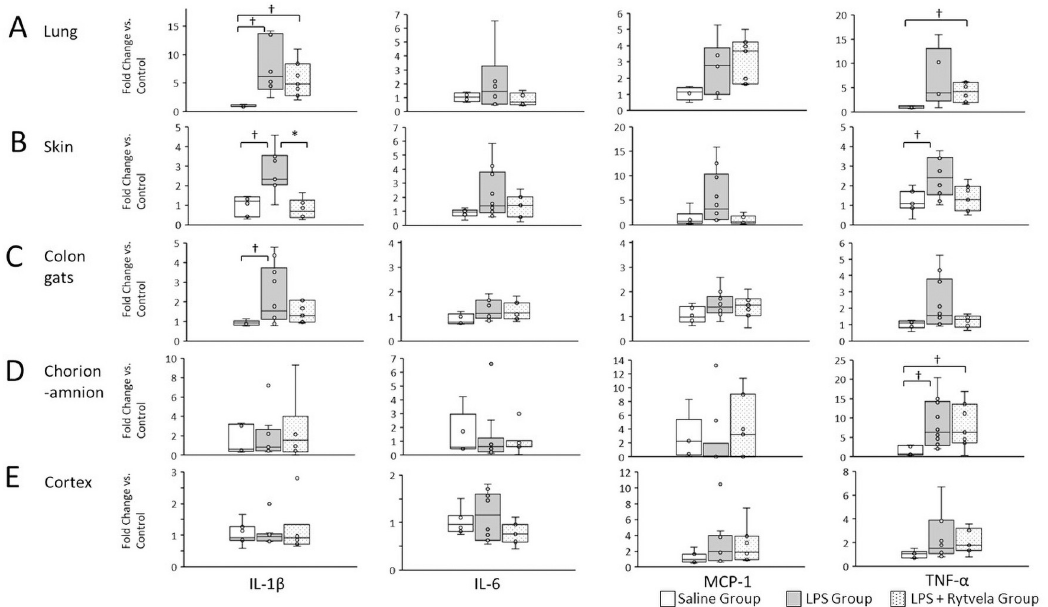
Fig 5. Histological assessment of fetal lung. A , Plots show median, 25th, and 75th percentile ranges as boxes and 5th to 95th percentile as error bars. LPS Group increased inflammation score in fetal lung tissue relative to Saline Group. � p < .05 between the Saline Group and the LPS Group. Representative sections of tissue from B , Saline Group (score = 0); C , LPS Group (score = 2); D , LPS + rytvela Group (score = 1). Inflammatory cells are indicated by arrows . Scale bar : 100 μ m. n = 7–10 animals/group. LPS,